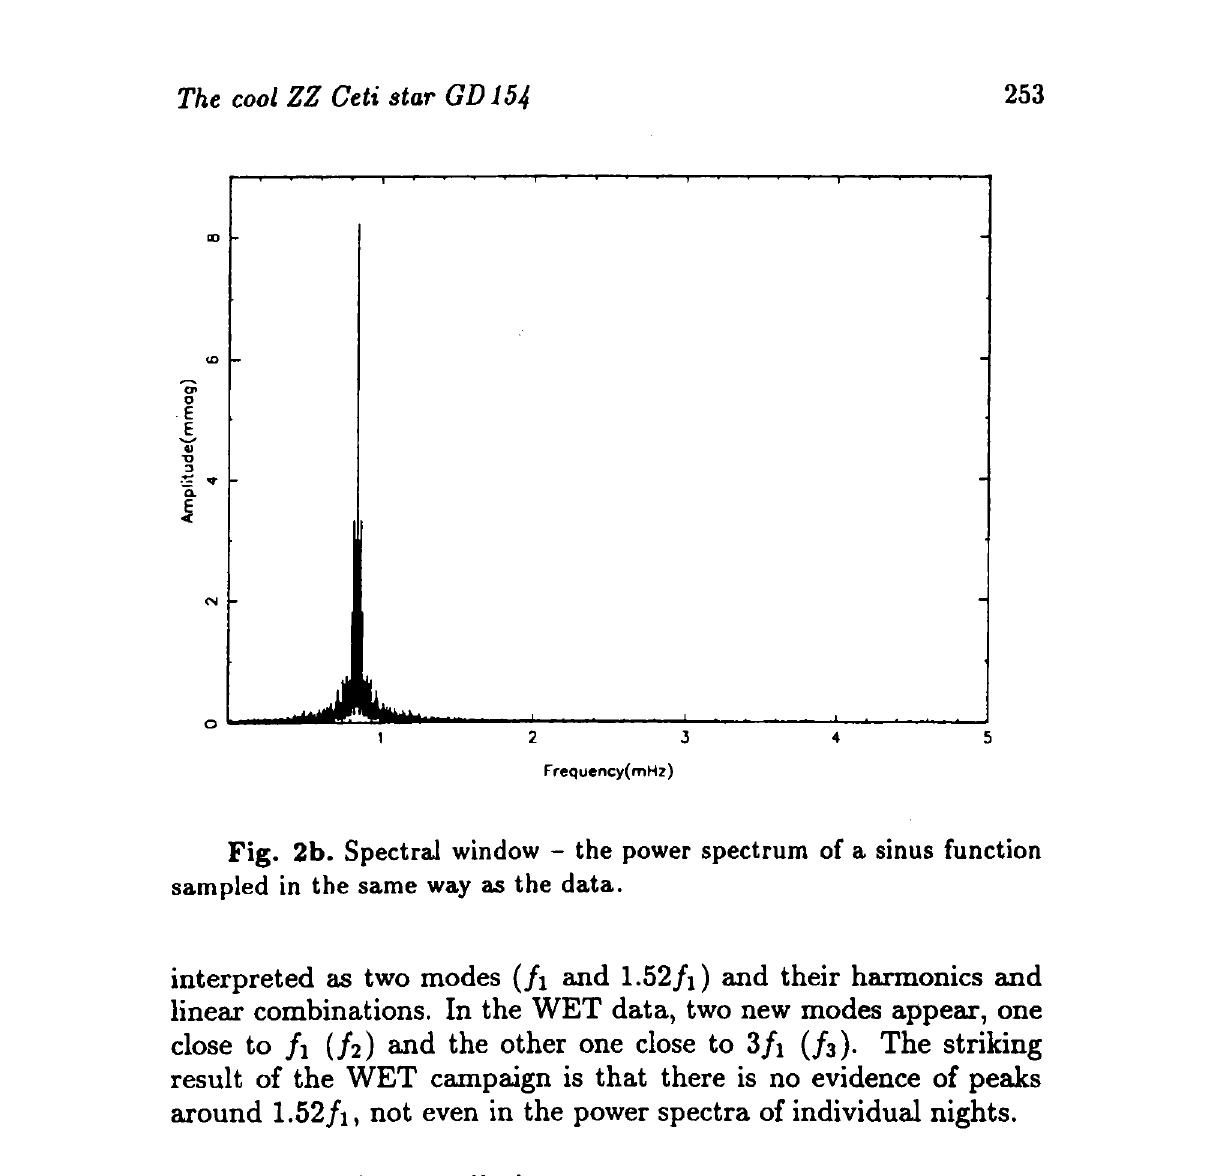
Fig. 2b. Spectral window - the power spectrum of a sinus function sampled in the same way as the